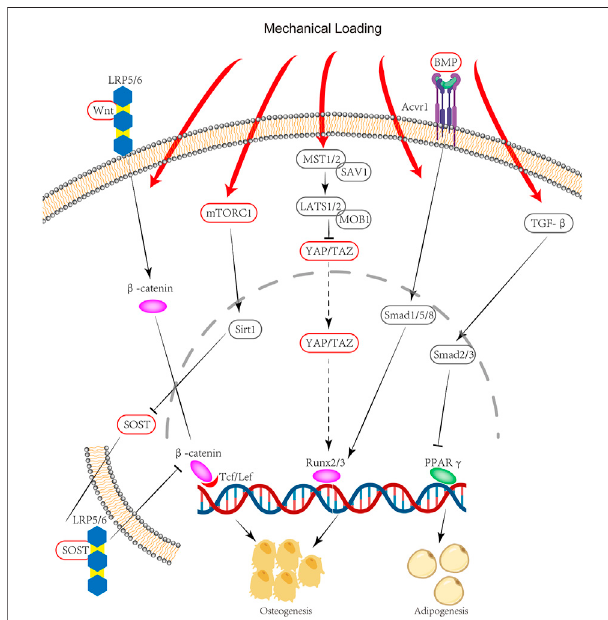
FIGURE 2 | Signaling pathway of HO due to mechanical stimulation: Mechanical stimulation through mTORC1 leads to an increase in Sirt1 translocation into the nucleus, followed by a decrease in SOST secretion. SOST can bind to LRP5/6 to inhibit β -catenin. Mechanical loading can also activate Runx2/3 gene expression through YAP/TAZ. Thus mechanical stimulation promotes osteogenic gene expression through mTORC1 and YAP/TAZ. Meanwhile, mechanical stimulation can inhibit PPAR γ gene expression through the TGF- β pathway, thereby suppressing lipogenic differentiation. These combined effects lead to a stem cell fate